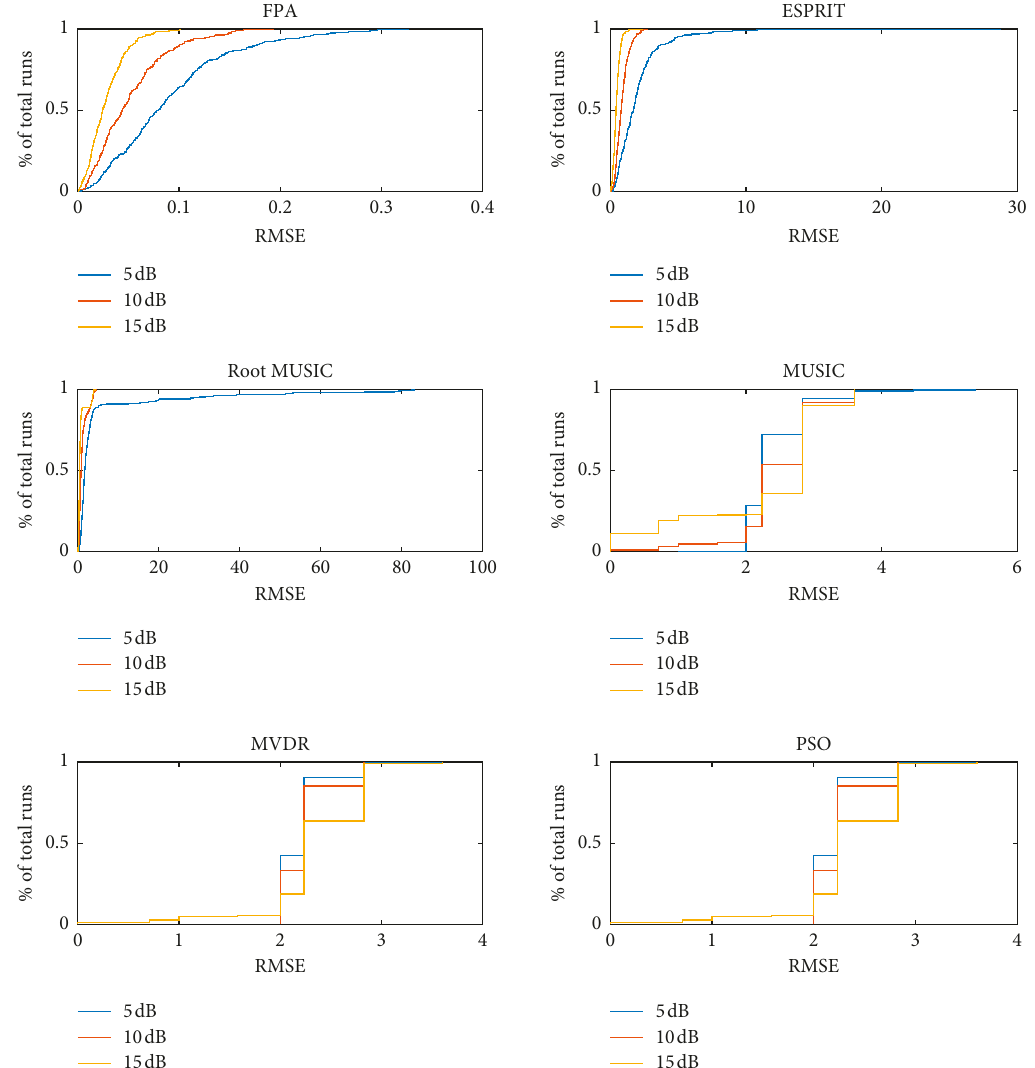
Figure 15: CDF of RMSE for two